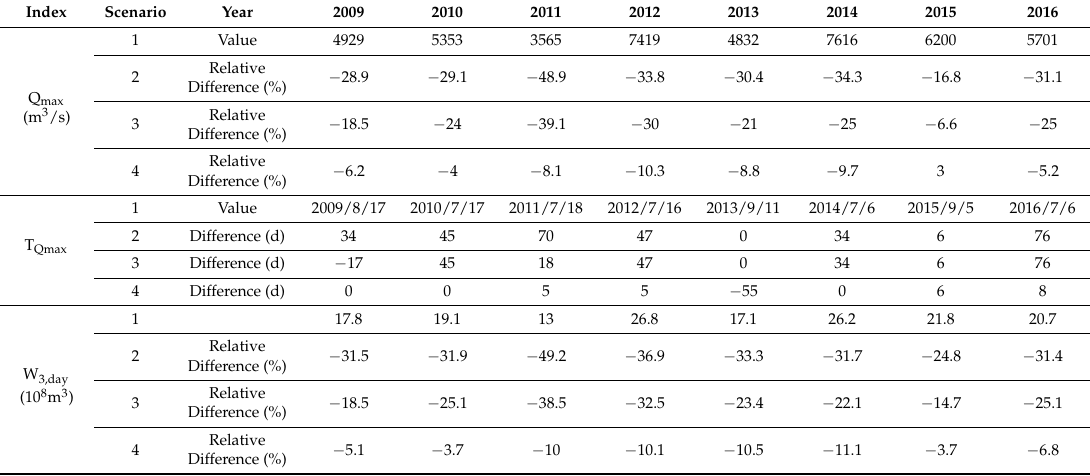
Figure 5. The daily simulation results of runoff (2009–2016) at Ertan station (Scenarios 1–4). Table 6. Flood characteristics analysis at Ertan station (Scenarios 1–4). (Q max represents annual maximum peak flow, T Qmax represents peak time, and W 3,day represents maximum three-day flood